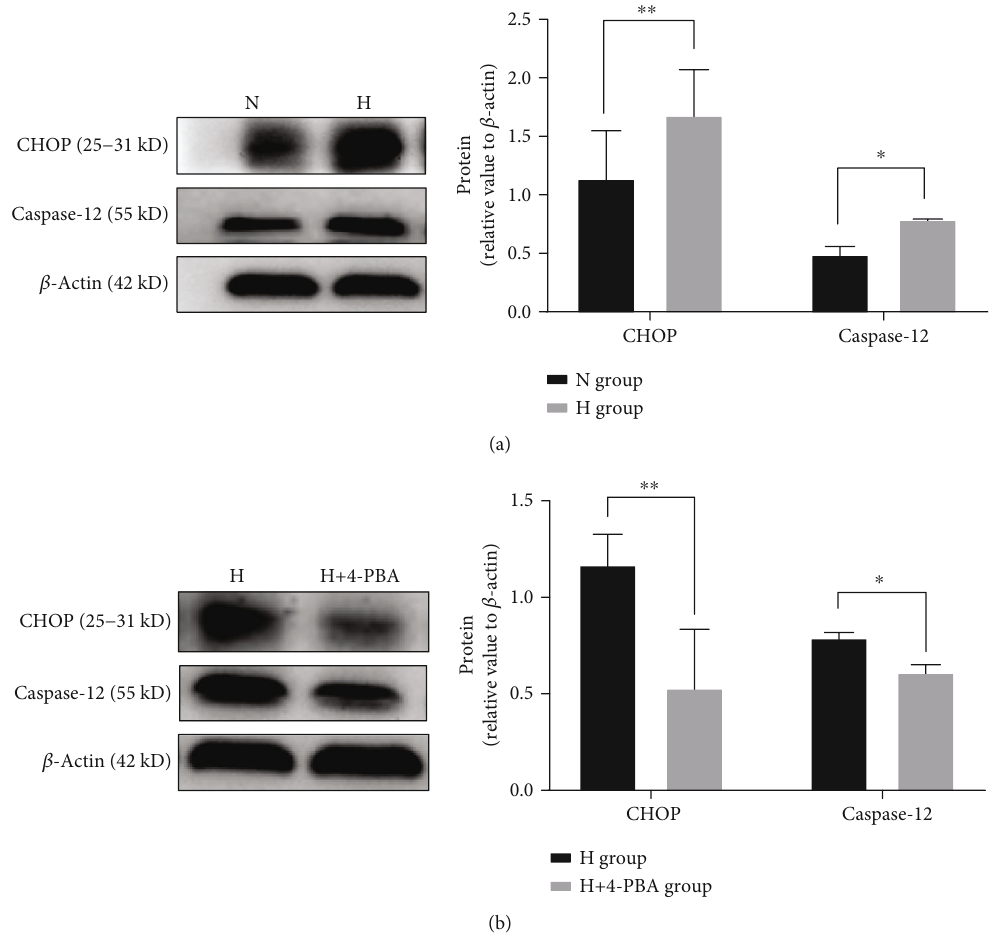
Figure 4: Expression of CHOP and caspase-12 in β -cells treated with di ff erent concentrations of T3. Western blotting analysis showed that (a) the expression of CHOP and caspase-12 in the H group was signi fi cantly higher than that in the N group, and (b) the expression of CHOP and caspase-12 in the H+4-PBA group was signi fi cantly lower than that in the H group ( n = 3 , ∗ p < 0 : 05 , ∗∗ p < 0 : 01